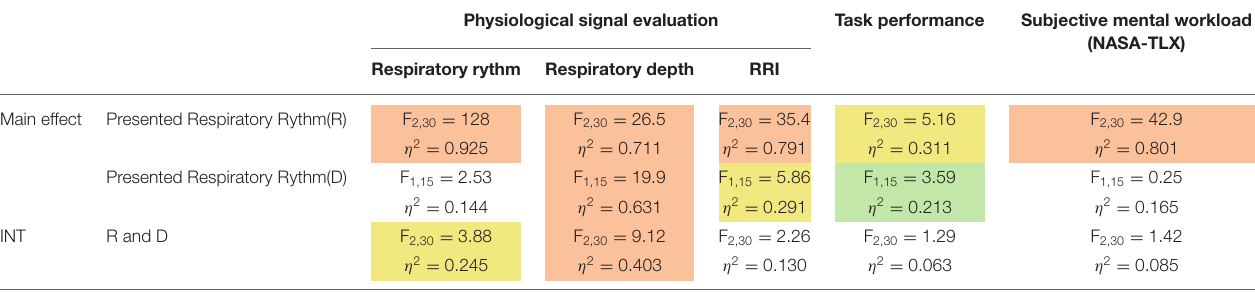
TABLE 1 | Results of two-way repeated ANOVA with presented respiratory rhythm and depth. Physiological signal evaluation